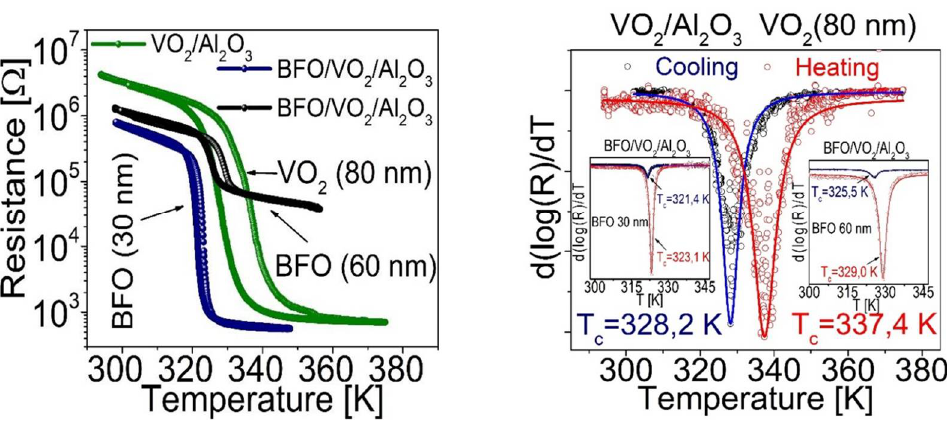
Figure 14. ( left ) Resistance curves as a function of temperature for VO 2 /Al 2 O 3 (VO 2 80 nm), BFO/VO 2 /Al 2 O 3 (BFO layer of 30 nm) and BFO/VO 2 /Al 2 O 3 (BFO layer of 60 nm) ( right ) derived from electrical resistance as a function of temperature for the films obtained.